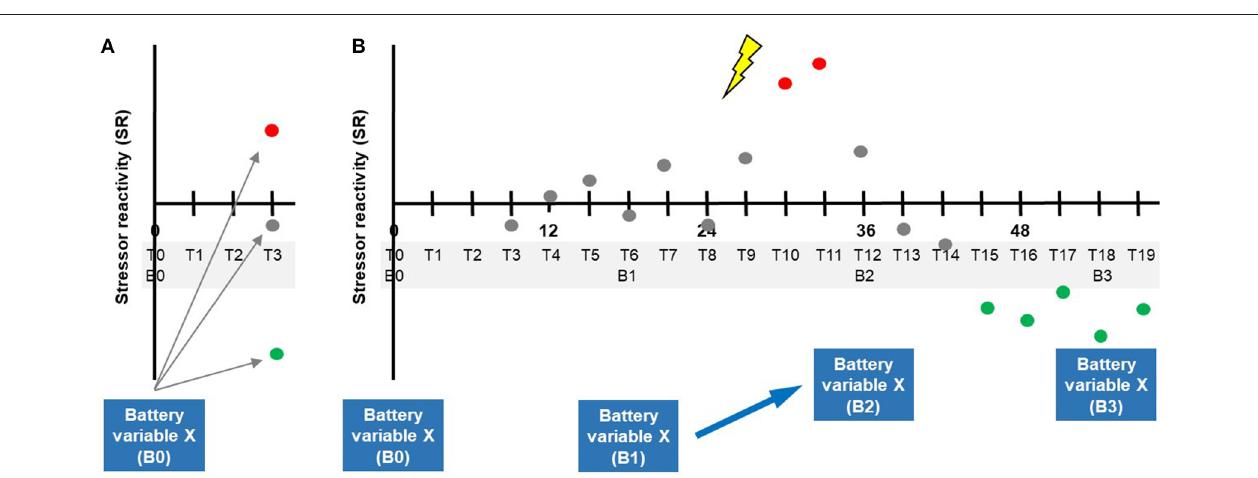
FIGURE 6 | Potential relationships between testing battery measurements and time courses of stressor reactivity. (A) Prediction of future SR (here SR T1 − T3 ) by baseline (B0) battery variable X. (B) Hypothetical scenario where, under the influence of significant stressor exposure (lightning bolt), an individual with normal stressor reactivity (gray) improves on a battery measurement X of a resilience factor from B1 to B2 (indicated by the arrow) and where his/her SR decreases (turns green) after an initial increase evoked by the acute stressor effect. This illustrates a lasting change in how the system copes with